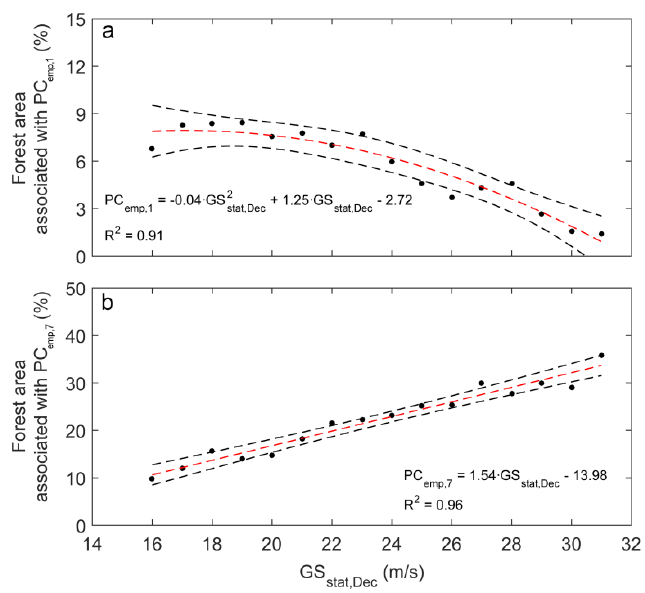
Figure 6. ( a ) Proportion of forest area associated with empirical storm damage probability class 1 ( PC emp,1 ) and ( b ) proportion of forest area associated with empirical storm damage probability class 7 ( PC emp,7 ) as a function of statistical gust speed of December for a return period of five years ( GS stat,Dec ). The red dashed line is the best-fit curve; the black dashed lines indicate the 95% regression parameter confidence intervals.